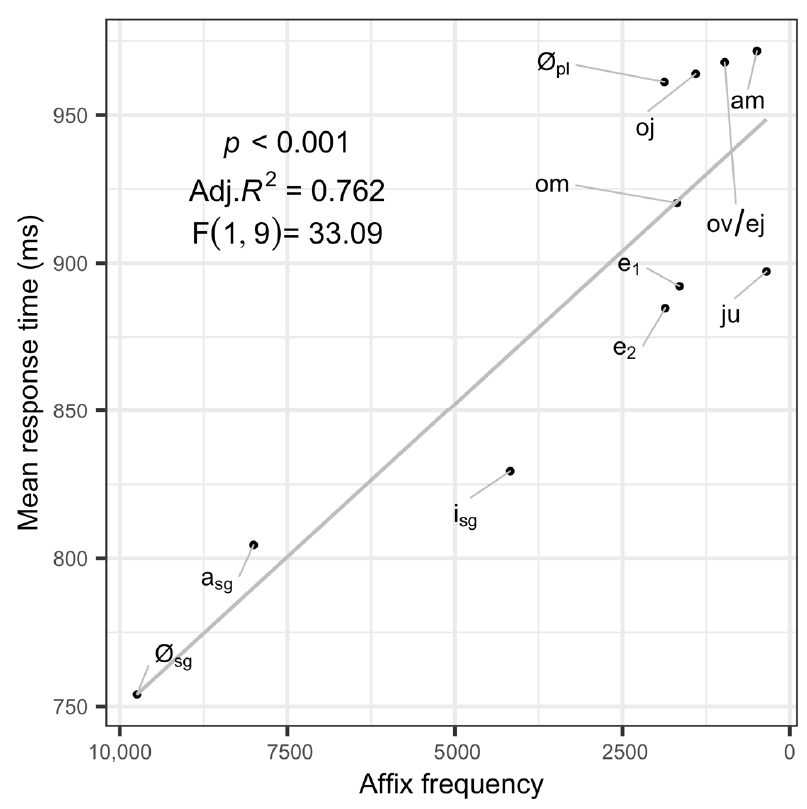
Figure 3. Effect of affix frequency on mean response time by